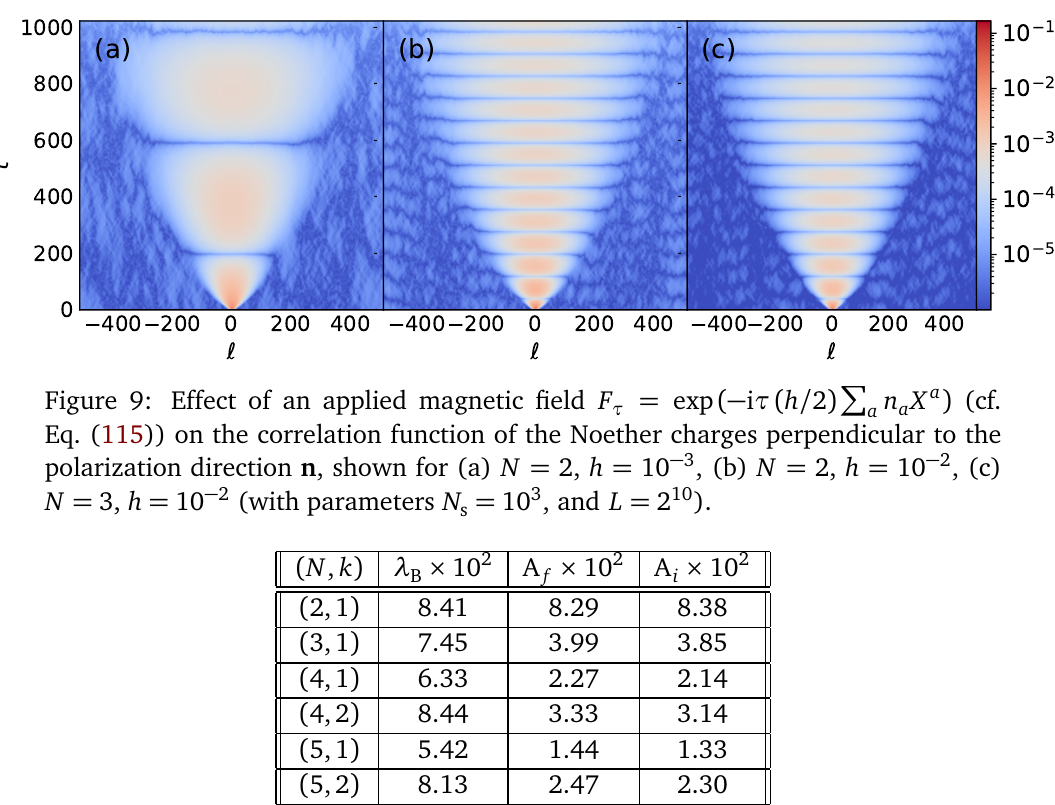
Table 1: Numerical values of the Burger’s coupling constant λ amplitude (height) A, characterizing stationary KPZ profiles computed for several lowest dimensions N and ranks k . Parameters ( λ scaling function (114). Amplitudes A cepts of the equal-space correlator C ( 0, t ) shown in Figure 6. The last line pertains to the unitary symplectic case (see Figure